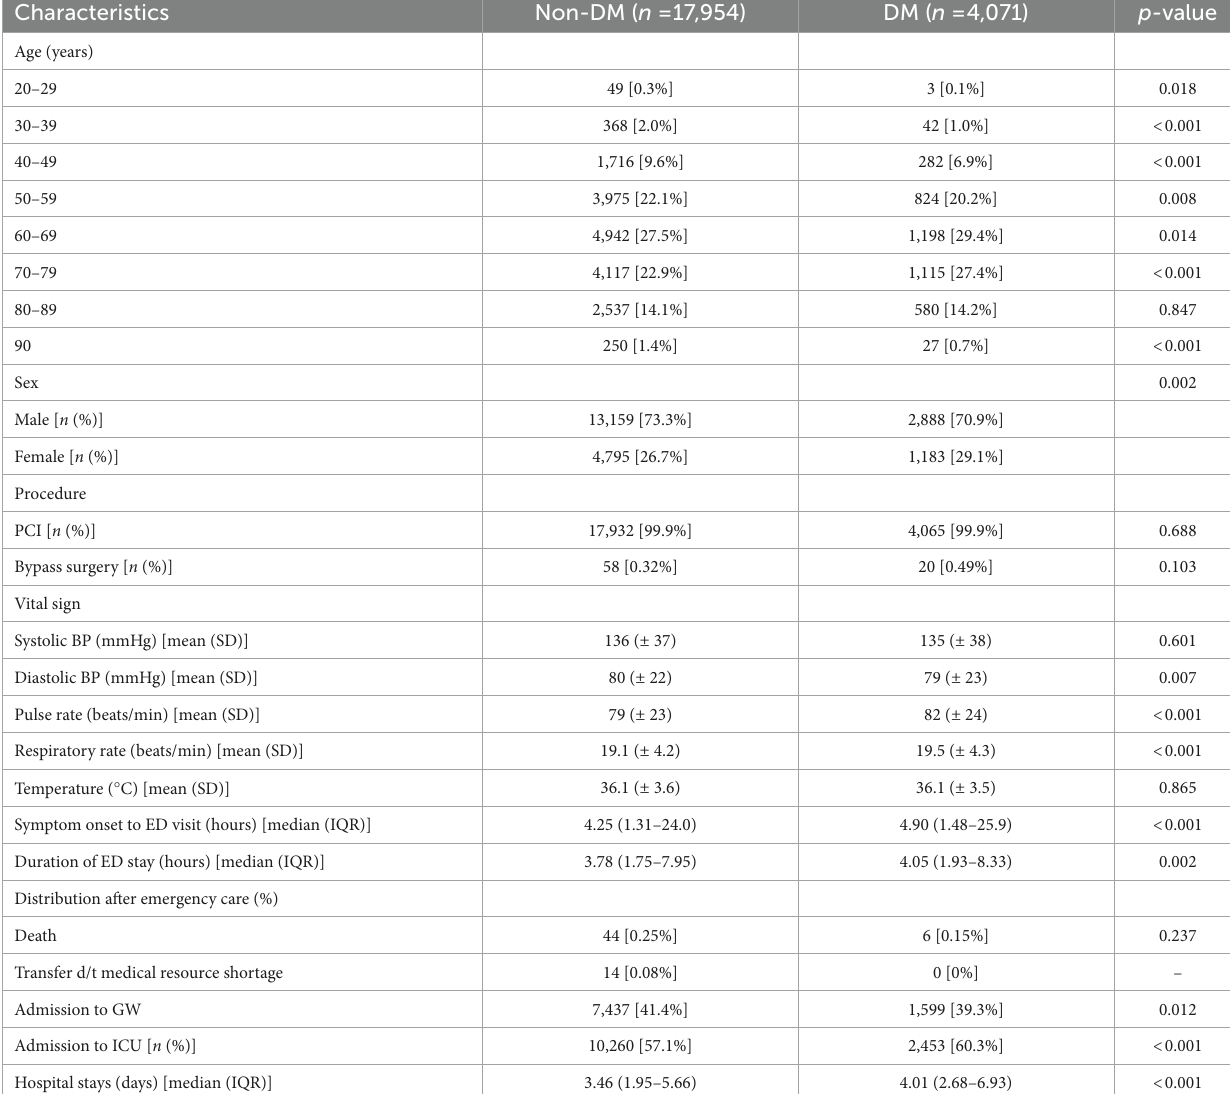
TABLE 2 Baseline characteristics of patients with AMI with and without comorbid DM during the outbreak period. Characteristics